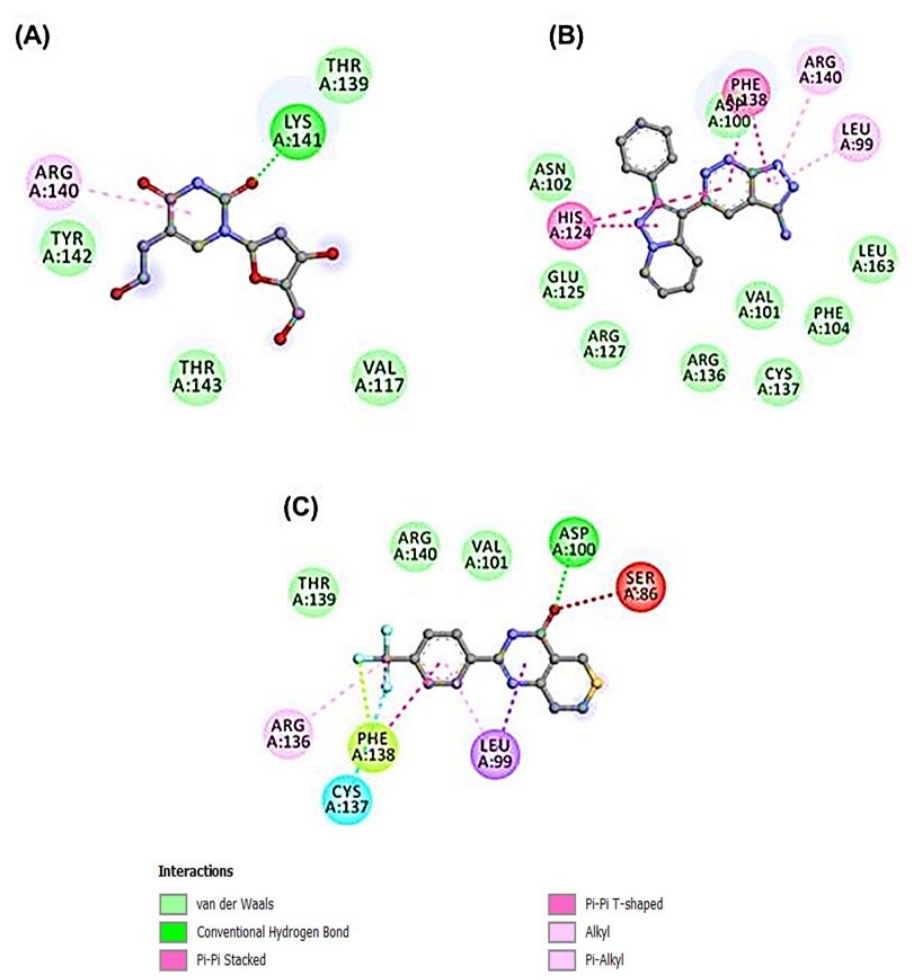
Figure 6. Molecular Interactions obtained from Molecular Dynamics Simulation of three complexes for a period of 100 ns. ( A ) BVDU ( B ) FR180204 ( C )